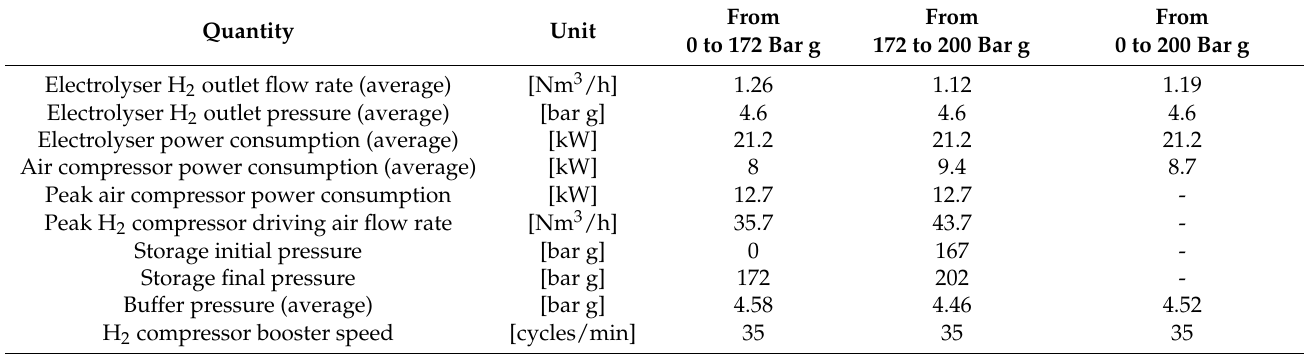
From From From 0 to 172 Bar g 172 to 200 Bar g 0 to 200 Bar g